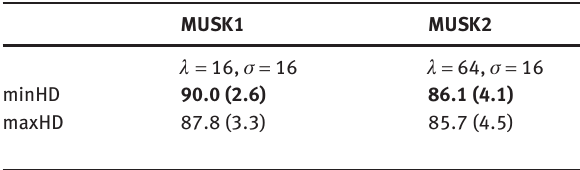
Bold typeface indicates significant